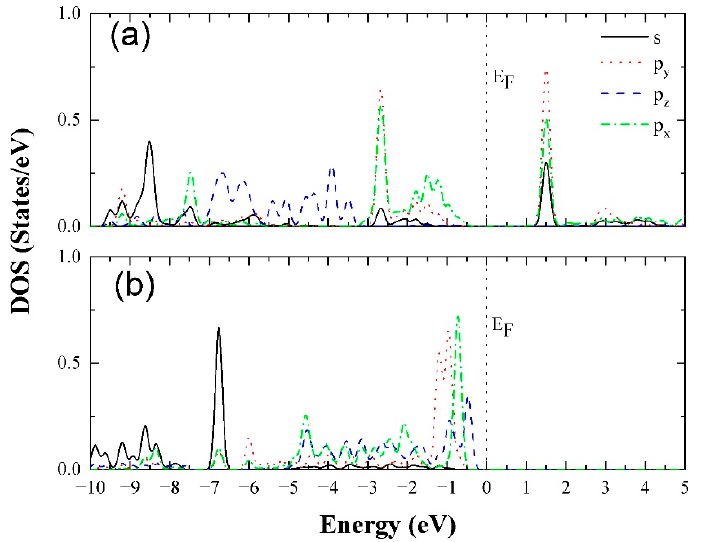
Figure 5. (Color online) The partial densities of states (DOSs) of the carbon atom with one of its connective hydrogens removed in the initial ( a ) and relaxed ( b ) structures for the R2